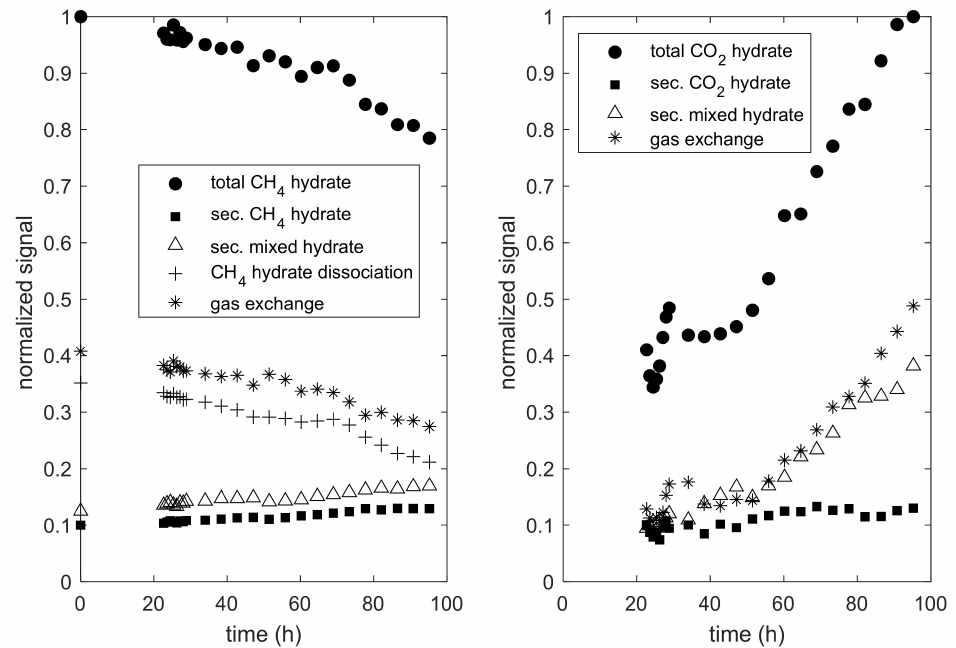
Figure 4. Evolution of the total gas-hydrate signal of experiment NoFlow and evolution of the specific processes (see text for explanation). Left: CH 4 hydrate; right: CO 2